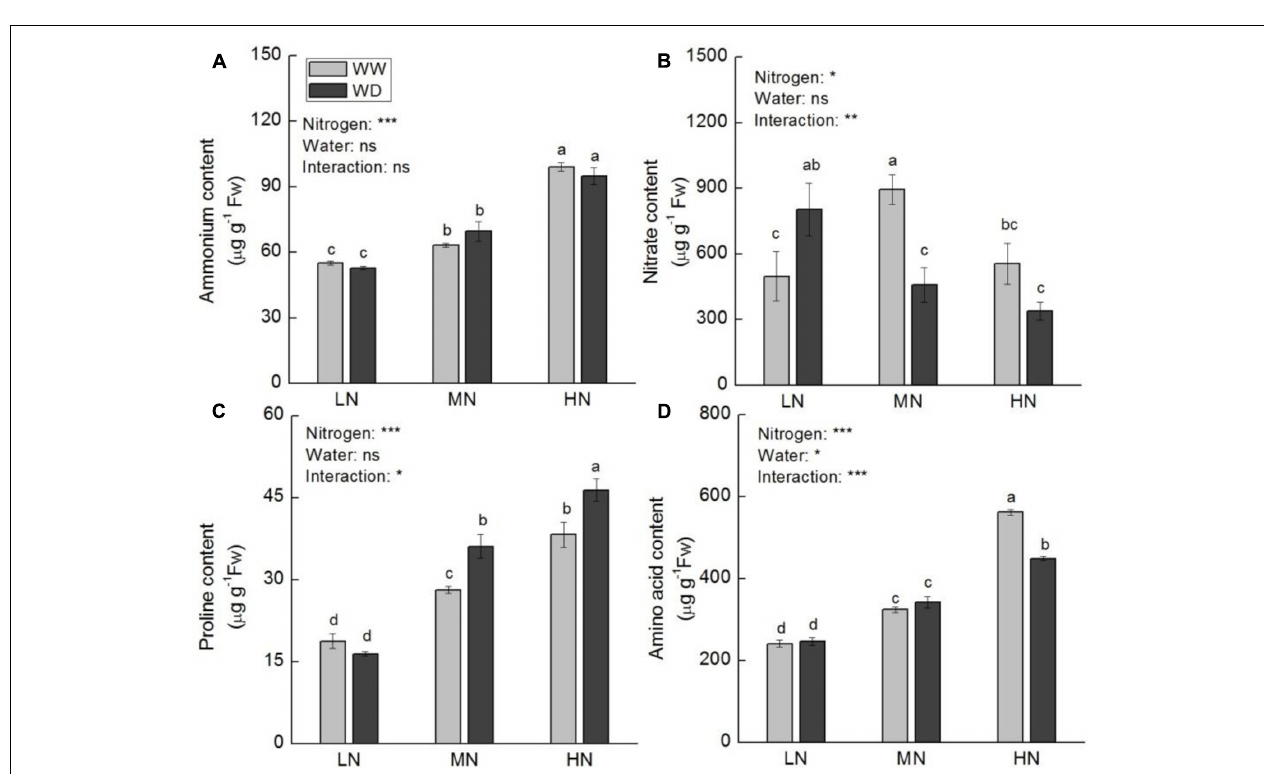
FIGURE 5 | Comparison in the contents of total leaf nitrogen (A) and soluble protein (B) in rice plants grown udner different nitrogen and water conditions. Data refers to mean ± SE ( n = 4). P -values of the two-way ANOVAs of nitrogen, water, and their interaction are indicated: ns, not significant; ∗ P < 0.05; ∗∗ P < 0.01; ∗∗∗ P < 0.001. Bars with the same letter are not significantly different by LSD test. WD, water deficit; WW, well-watered.